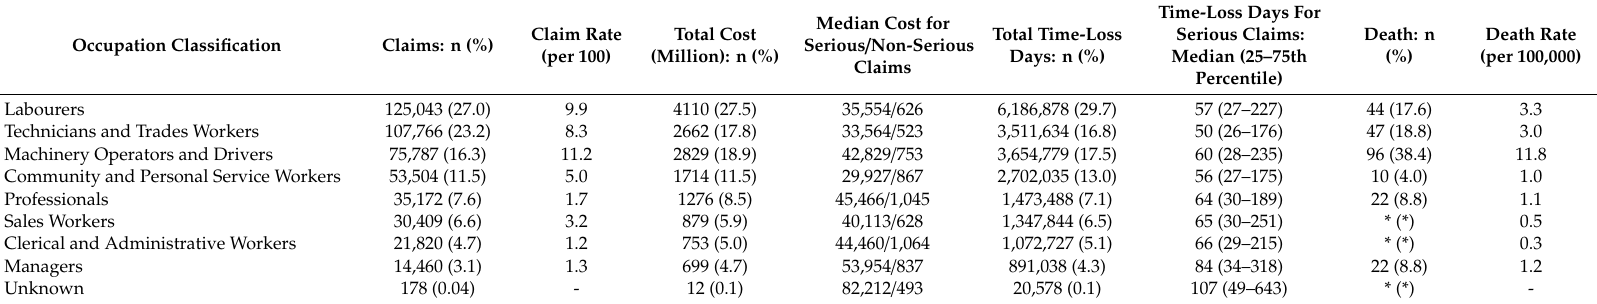
Table 2. The number of claims, percentage, compensation payment, time-loss days, and deaths by occupation, South Australia,